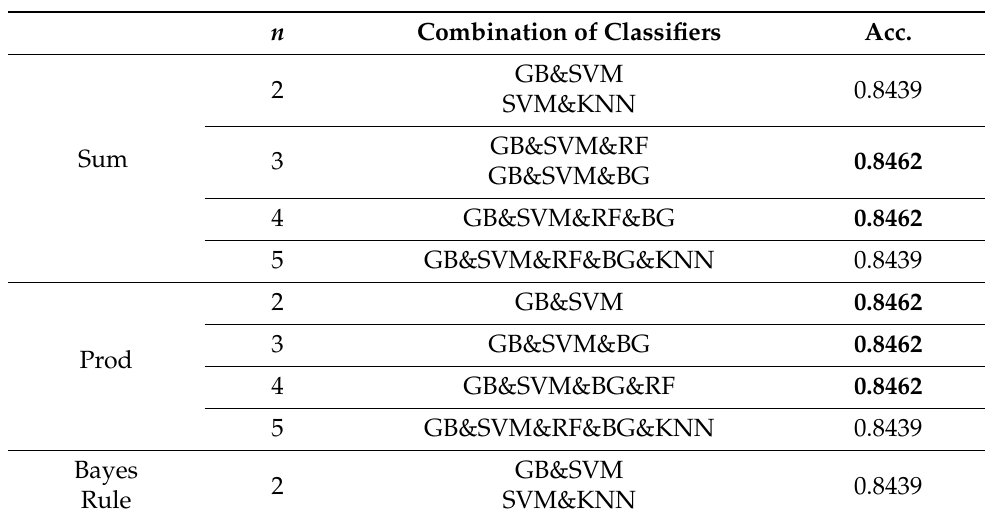
Table 2. The results of the combination of the classifiers in gender recognition using different fusion strategies. n is the number of classifiers involved in the fusion process. The numbers in bold are the best results.